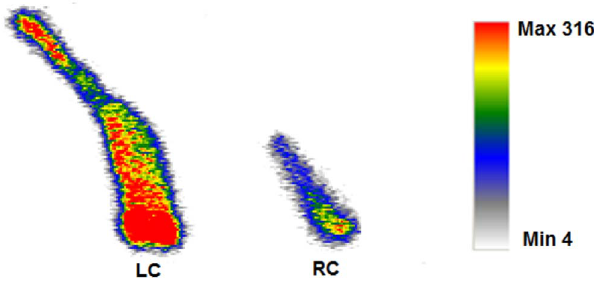
Figure 4. Autoradiography imaging for confirmatory purpose. Ex vivo autoradiography from a mouse injected with 18 F-FDG. The ligated left carotid artery (LC) showed high amount of 18 F-FDG uptake compared to the non-ligated right carotid artery (RC).